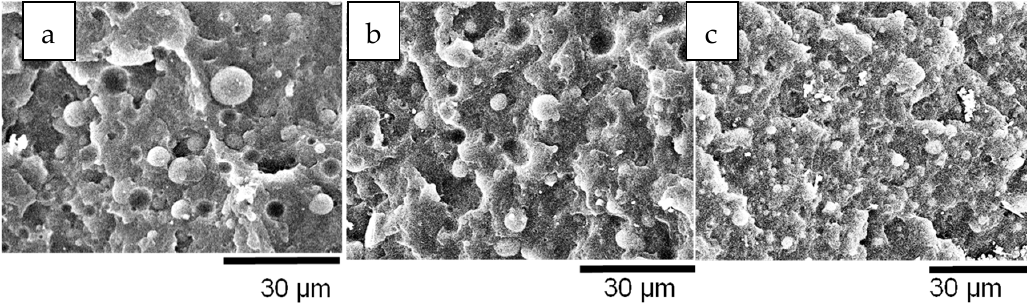
Figure 5. SEM images of PBNANO-hphoM with ( a ) 3% ( b ) 7%, and ( c ) 12% TiO 2 . Table 3. Number-average diameter (d n ) and particle size distribution (D) of 80rPP/20rPET/TiO 2 nanocomposite blends.